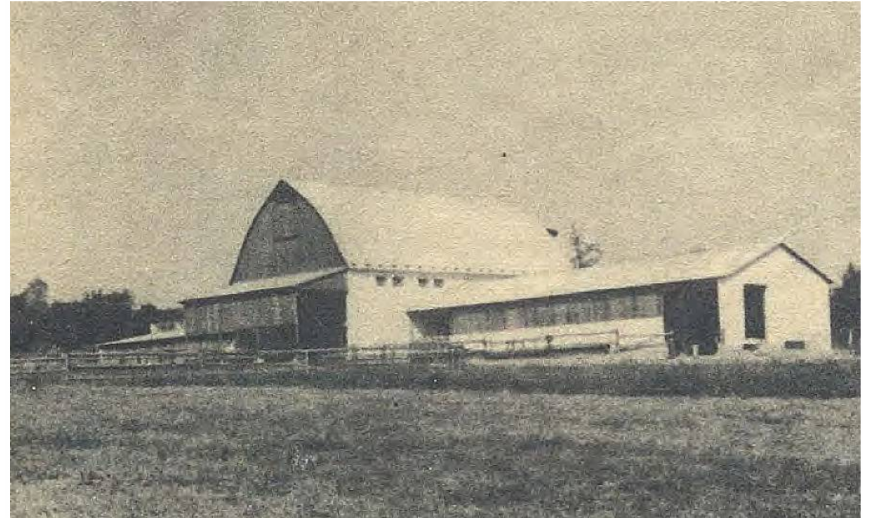
Figure 1. A stable for young cattle in the village of Libˇejovice (1958)